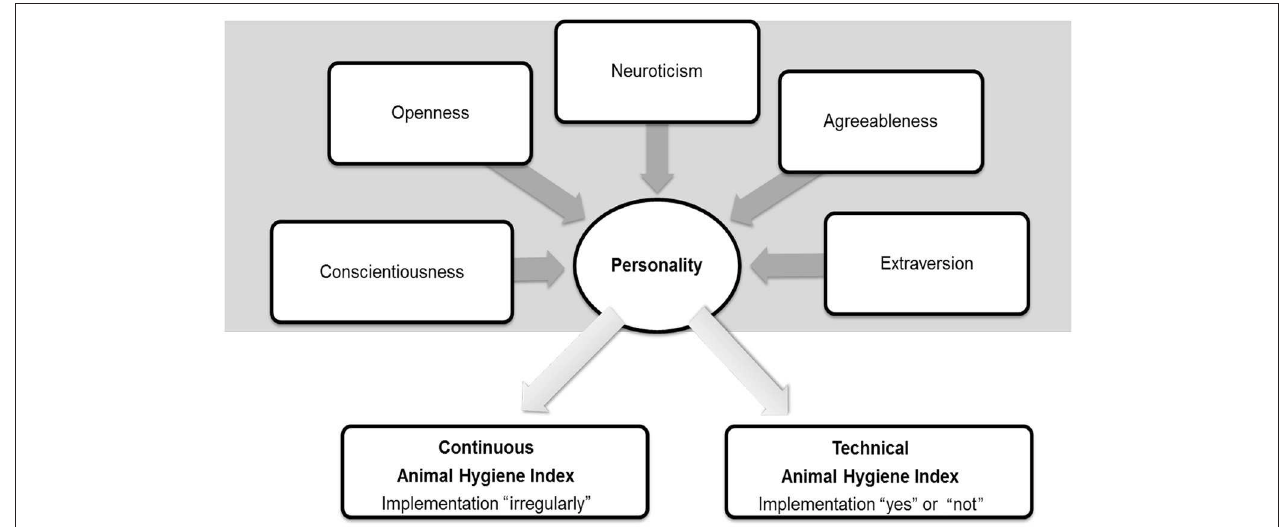
FIGURE 1 | Big-five model with the five personality traits aligning the “continuous animal hygiene index” and the “technical animal hygiene index” with their frequencies of implementation of measures.